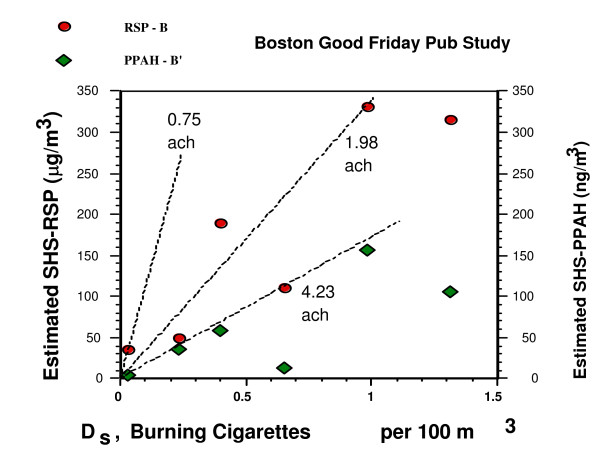
Pre-ban secondhand smoke respirable particulate, SHS-RSP, (total measured RSP – background RSP, B) in micrograms per cubic meter and SHS-PPAH concentration (total measured PPAH – background PPAH, B') in nanograms per cubic meter versus burning cigarette density Ds (active smokers observed per hundred cubic meters of space volume) and air exchange rate Cv in units of air changes per hour (ach) as calculated from RSP using the model of Repace (2005). The decay rates of PPAH are higher than for RSP. Background-subtraction values are arbitrarily chosen from measured open-window nonsmoking hotel room values. Data from Pub # 6 are omitted from this plot.